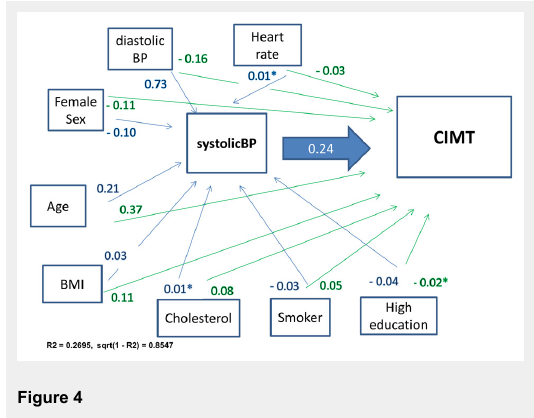
Path analyses: systolic blood pressure and carotid intima media thickness. Beta coefficients in blue: direct effect on systolic BP, in green: indirect effect on CIMT, mutually adjusted and adjusted for physical activity (non-significant impact on BP and CIMT); R2 = variance explained by path model; sqrt(1–r2) = estimated